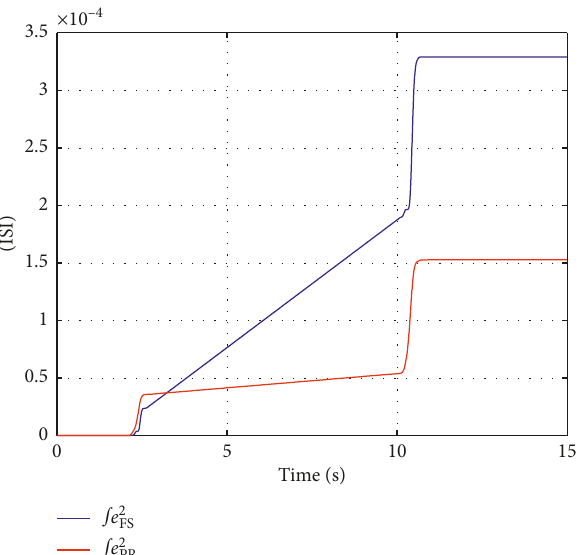
Figure 9: Performance index of the error.